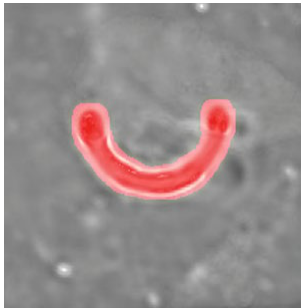
Fig. 6. The microchannel area on the LTCC